Question: Describe this figure in one sentence.
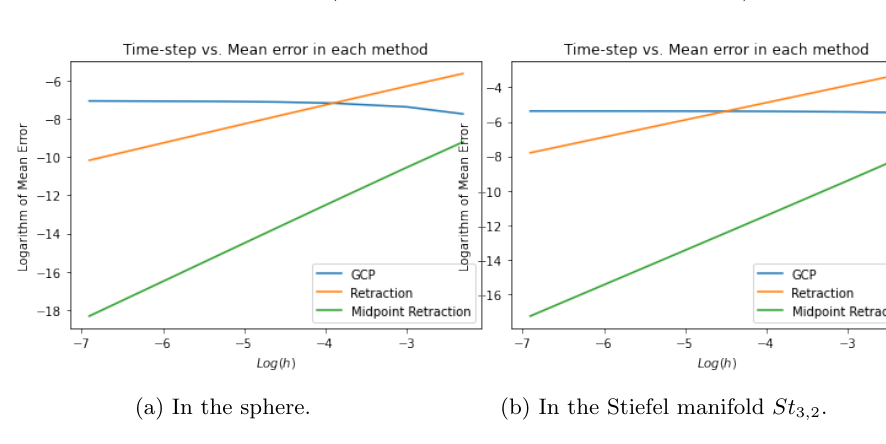
Answer: Comparison of mean error of adjusted Casteljau algorithm (GCP) with the mean error achieved by a retraction based method using different discretization maps (Retraction and Mid-point Retraction)